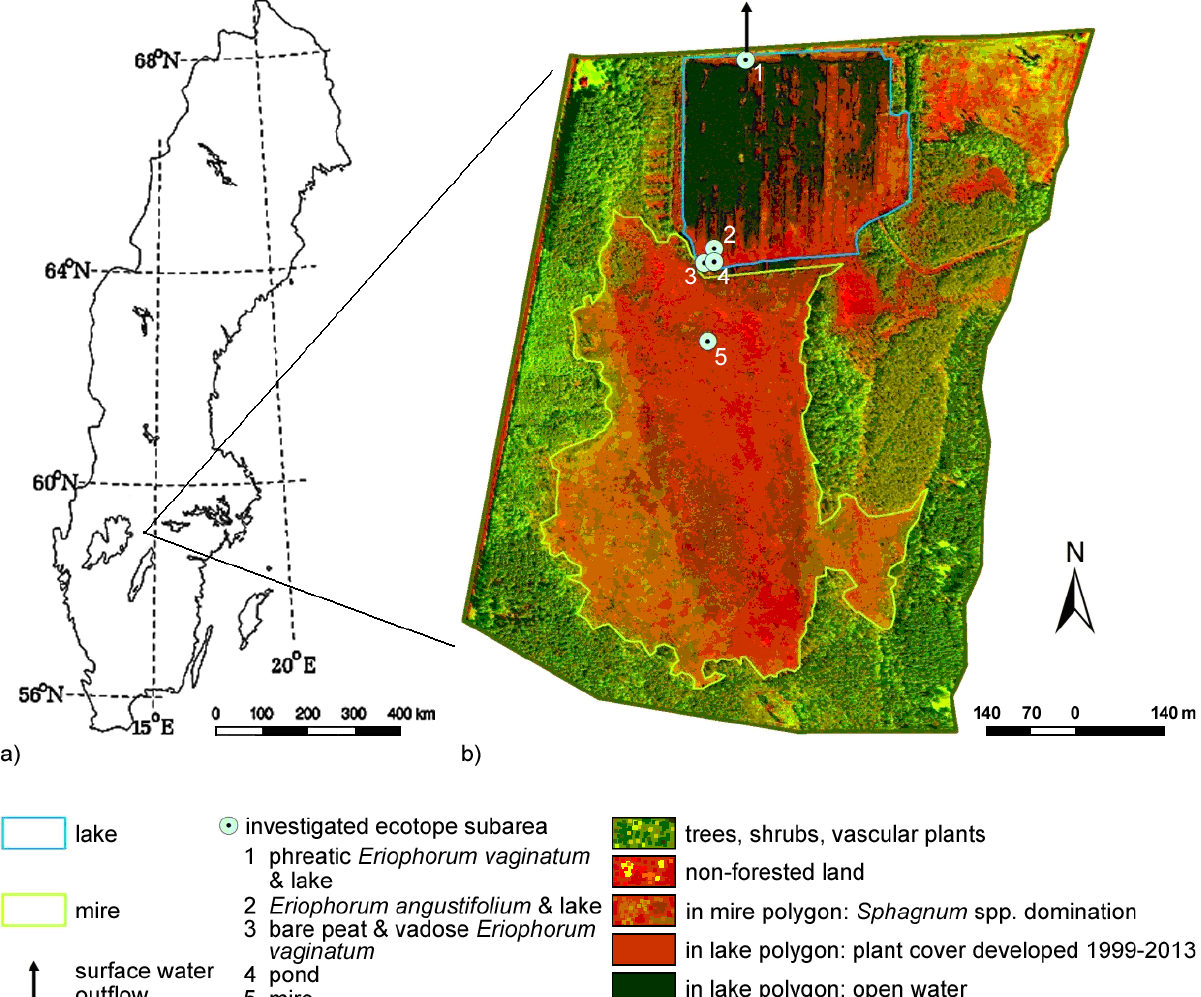
Figure 1. a) Map of Sweden showing the location of the Porla peatland; b) visualised Principal Component Analysis (PCA) layer of orthophoto (Lantmäteriet 2013) over the Porla study site, created as a RGB raster composite with red and green channels of Band 1 and Band 2 (PCA tool in ArcMap